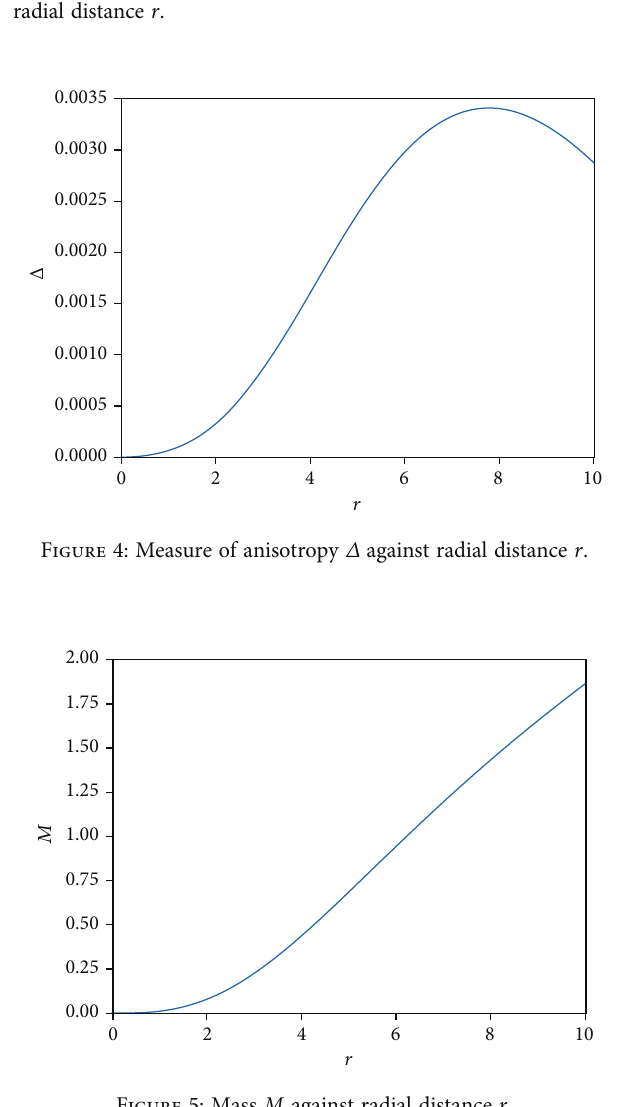
Figure 5: Mass M against radial distance r .